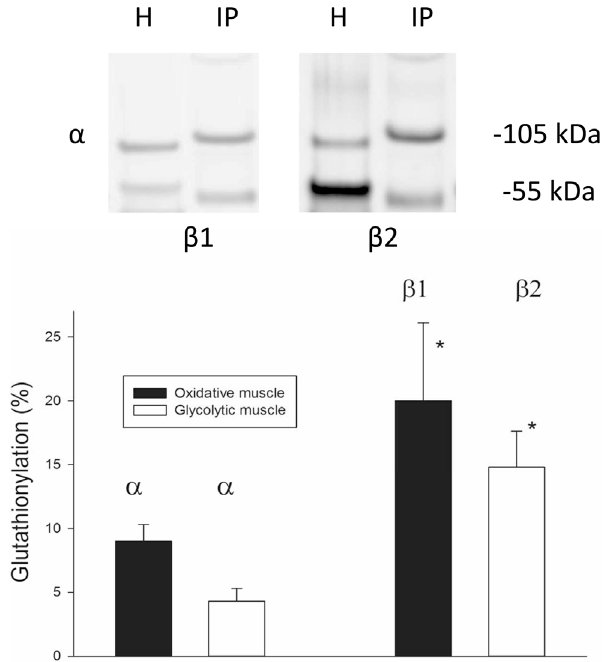
Figure 1. Glutathionylation in untreated muscle. Upper panel: Examples of Western blots of Na,K-ATPase a , b 1 and b 2 isoforms in homogenates and in the immunoprecipitate obtained with anti-GSH antibodies. The fraction of glutathionylated proteins was only 5–20%. To get a clear signal it was therefore necessary to immunoprecipitate from a larger (20 fold) amount of protein than used for the homogenate sample (which was probed for the total subunit content). H: isoforms detected in untreated muscle homogenate, 10 m g protein per lane, IP: isoforms detected in immunoprecipitate from 200 m g protein. Two antibodies were used successively on the same gel; first anti- b then anti- a . The figure bands originate from two gels. Pictures of uncropped gels and identification criteria are provided in file S1. Lower panel: Homogenates from oxidative and glycolytic muscle were immunopre- cipitated with an anti-GSH antibody and the precipitate immunoblotted with Na,K-ATPase isoform antibodies. The glutathionylation level was calculated relative to immunoblotted crude muscle homogenates. *: significantly different from the fraction of a isoform in the same muscle type. Mean + SEM shown, one oxidative and one glycolytic muscle from each of 6 animals. All samples run in duplicate.